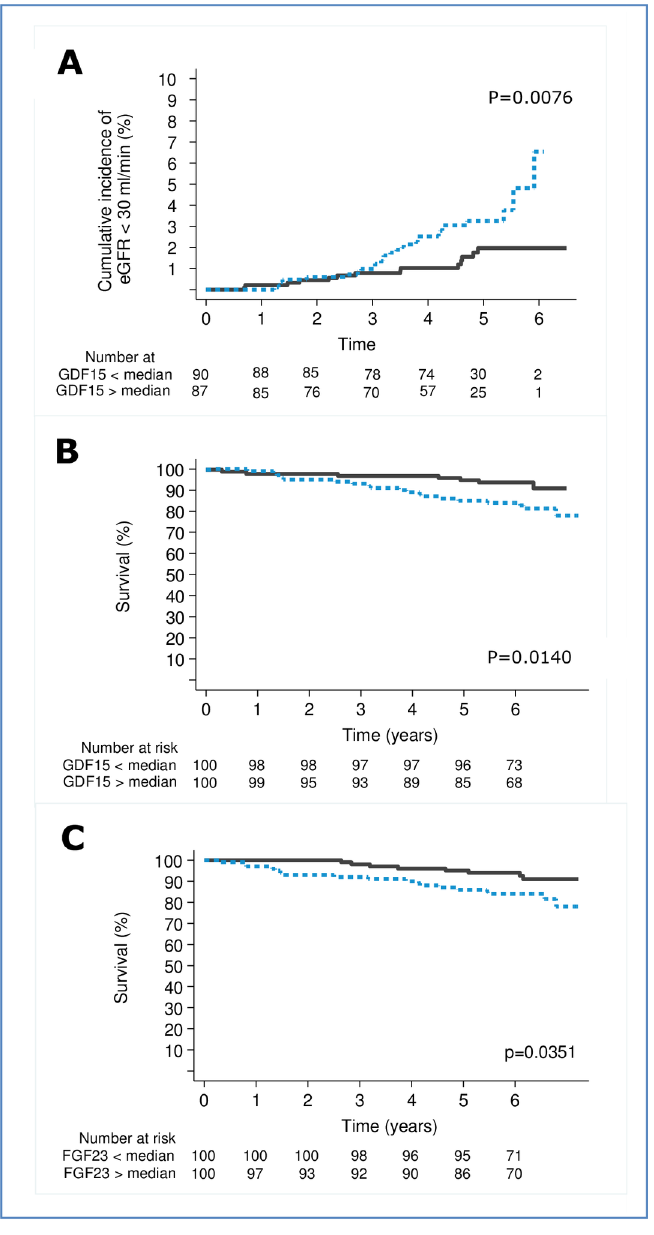
Fig 2. Kaplan-Meier plot of A. GDF-15 in relation to decline in eGFR > 30%, B. GDF-15 in relation to all-cause mortality, C. FGF-23 in relation to all-cause mortality Numbers refer to participants in each category at risk at the beginning of each 2 year interval. P-values based on log-rank